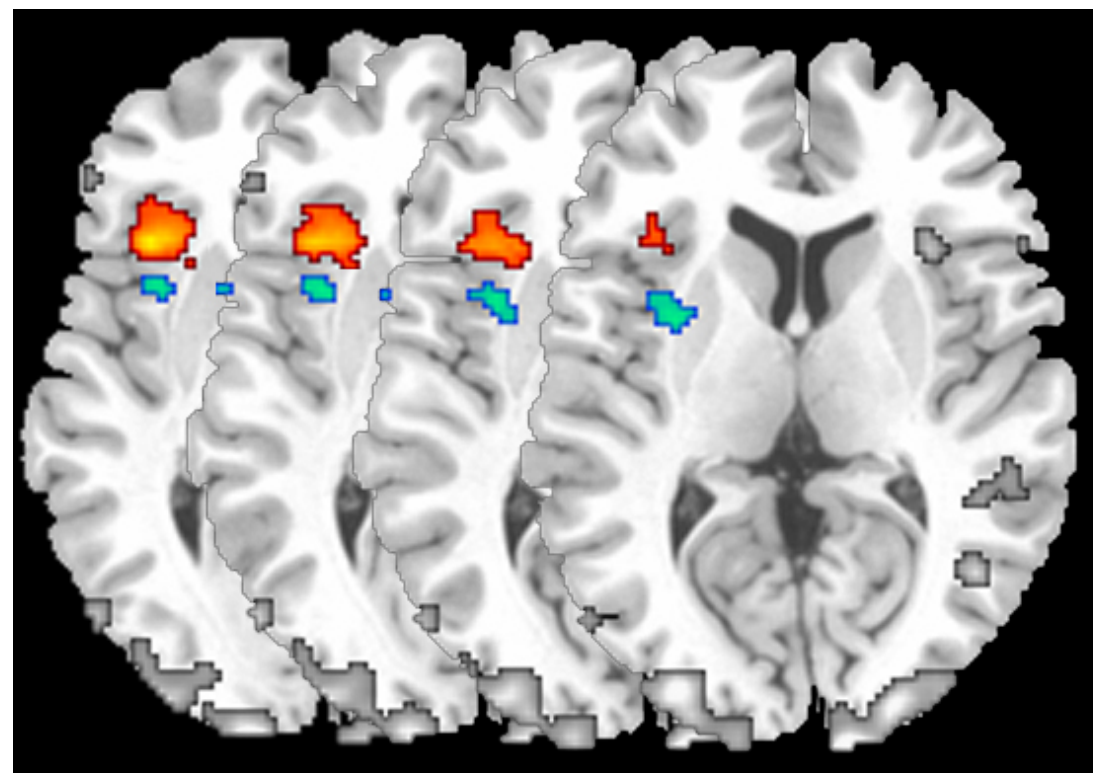
FIGURE 2. Dissociation of activation in the anterior and middle insular cortex elicited by perspective-taking instructions. Participants watched videos of patients undergoing painful medical treatment. The cluster in the anterior part of the insula (red to orange) shows activation irrespective of the perspective adopted by the study participants. The cluster in the mid-insula (blue to green) reflects higher signal change when participants adopted a first-person perspective as compared to adapting the perspective of the patient. It is worth noting that both perspectives activated the anterior insula, whereas the posterior cluster was specifically associated with the self- perspective (adapted from